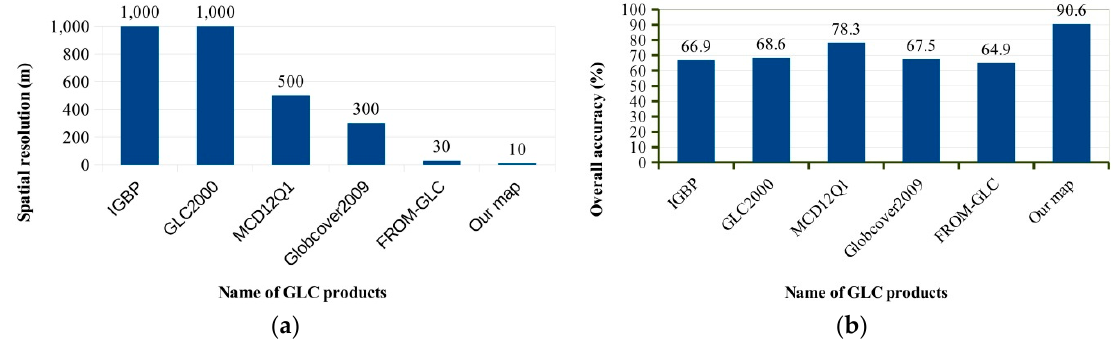
Figure 4. A comparison of our maps and previous global land cover maps in the spatial resolution ( a ) and in the overall accuracy ( b ) over Central Vietnam.